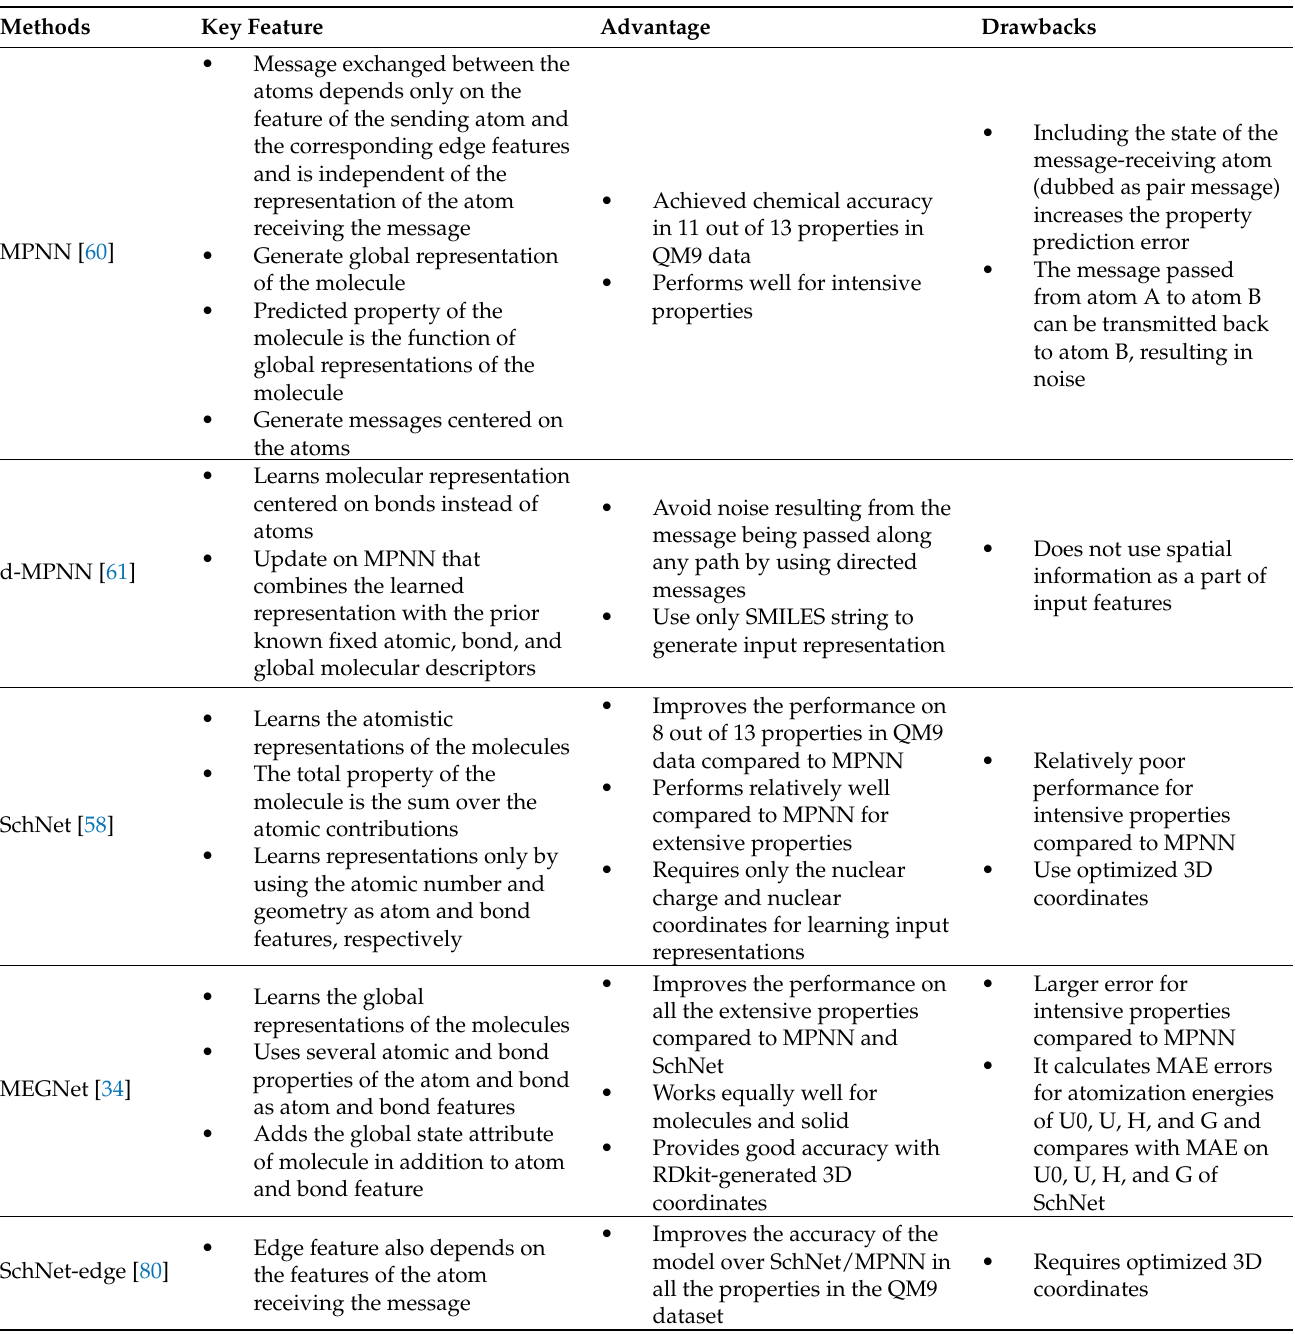
Table 1. Highlights and benchmark of predictive ML methods, their comparison, including their key features, advantages, and